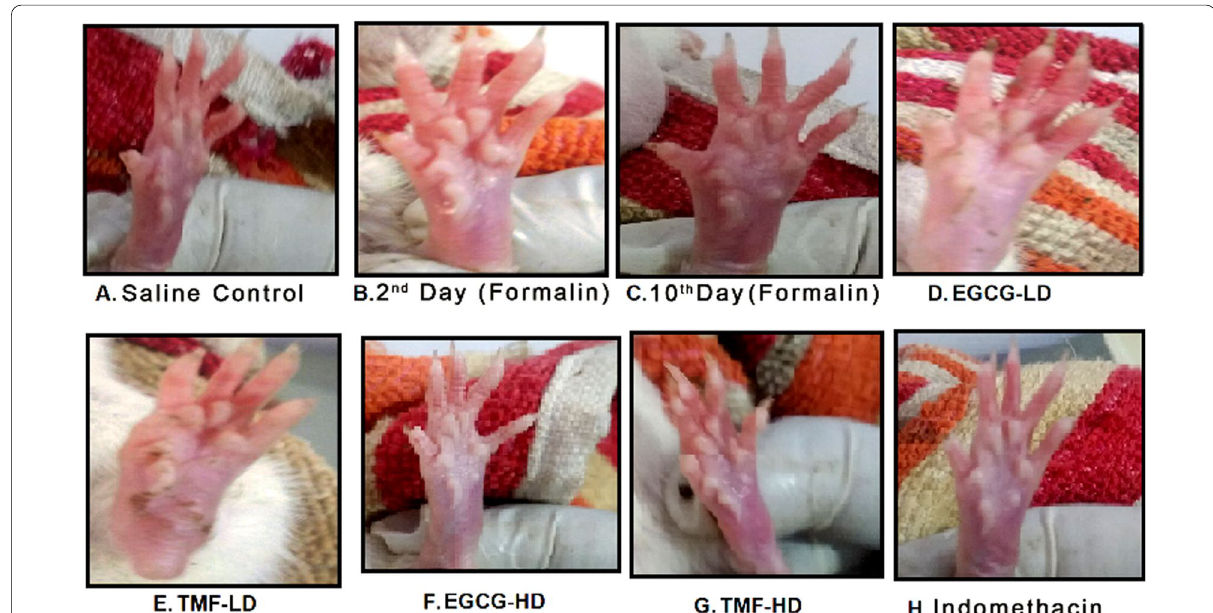
Fig. 5 Footpad image of SW rats: A Normal saline control; B , C Development of arthritis after formalin injection; D – H . Arthritic status at the footpad